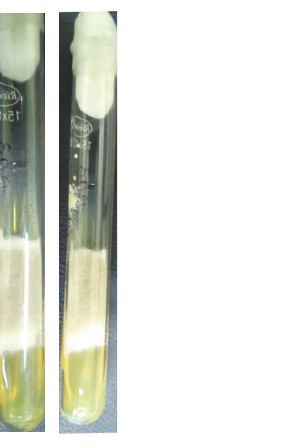
Figure 6: SDA slants incubated at 30 ∘ C and 45 ∘ C showing similar growth morphology after 48 hours of